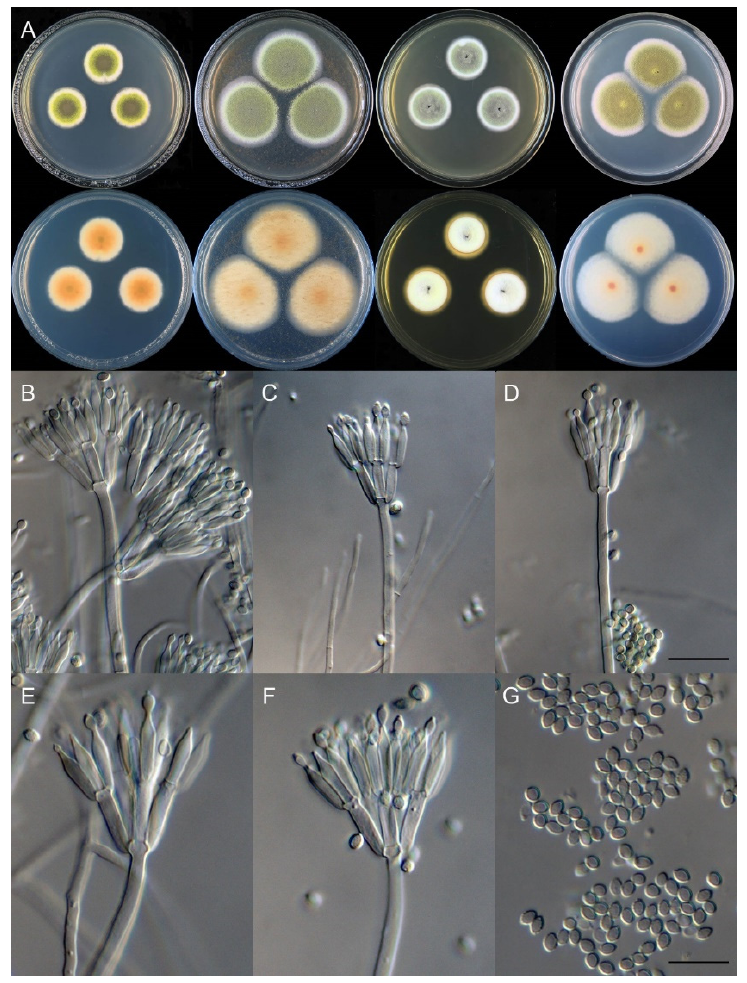
Figure 8. Talaromyces wushanicus (CS17-05). ( A ) Colonies: top row left to right, obverse CYA, MEA, YES, and PDA; bottom row left to right, reverse CYA, MEA, YES, and PDA; ( B – F ) Conidiophores; ( G ) Conidia. Bars: ( D ) 15 µm, applies also to ( B , C ); ( G ) 10 µm, applies also to ( E , F ). Fungal Names: FN570852